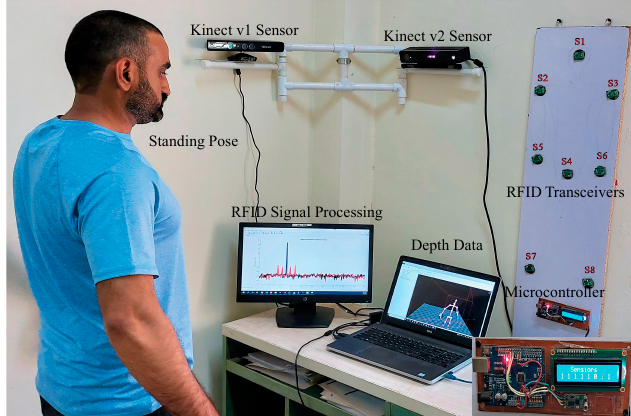
Figure 3. Testbed setup for dataset collection using Kinect and RFID sensors.